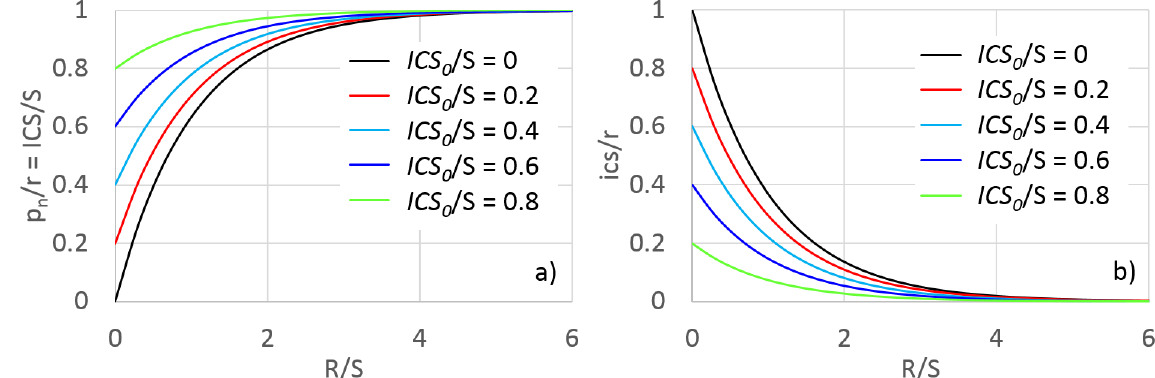
Figure 4. For different antecedent normalized water volume stored on the canopy, ICS 0 / S , ( a ) normalized interception volume, ICS / S , corresponding the normalized net rainfall intensity, p n / r , and ( b ) normalized interception intensity, ics / r , versus the normalized rainfall volume, R / S .